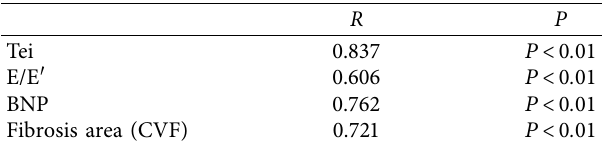
Figure 4: Masson staining of left ventricular myocardium of two groups ( × 200) sham: sham-operated group; 2K2C: 2K2C hypertension group collagenous fibers were in blue, while myocardial fibers were in red. Table 3: Pearson’s linear correlation analysis of SDC-4 level and diastolic